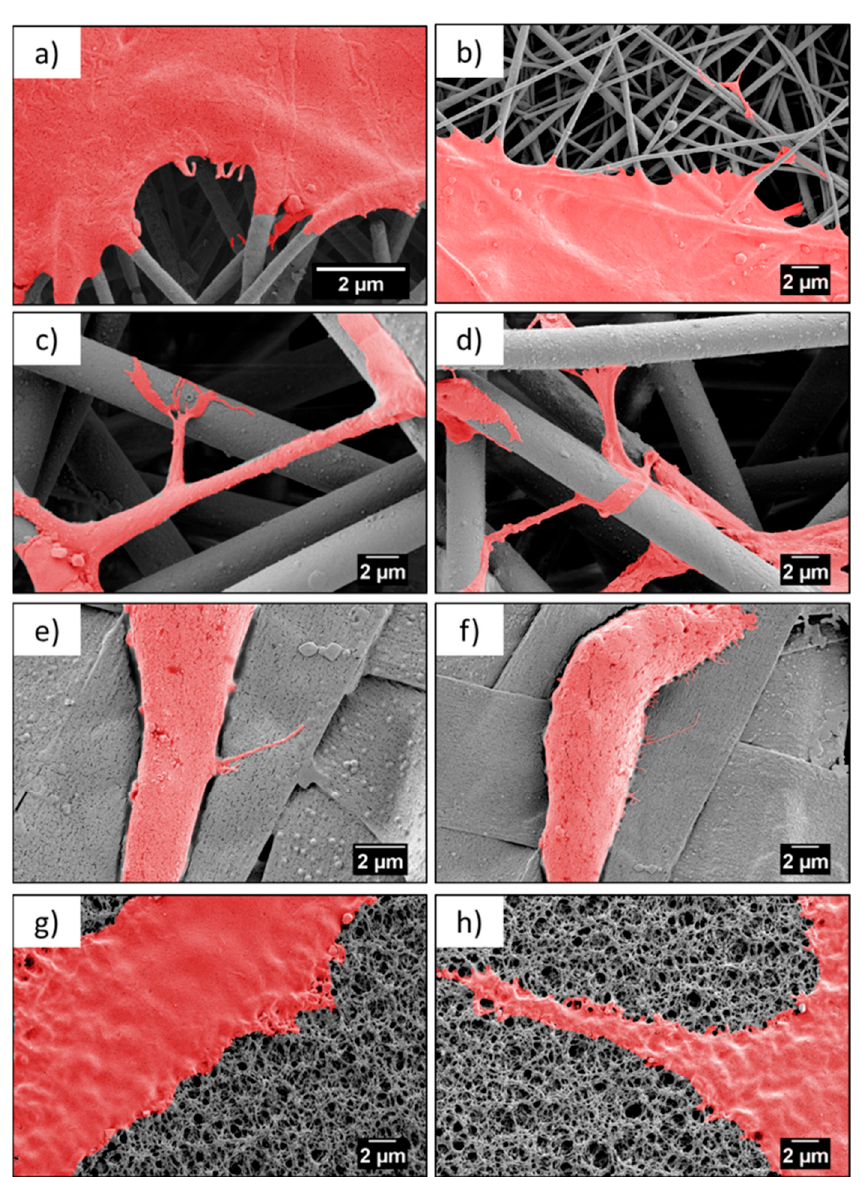
Figure 6. SEM micrographs showing cell attachment to a different type of scaffold, after three days—( a , b ) nanofibers, ( c , d ) microfibers, ( e , f ) ribbons, and ( g , f ) film